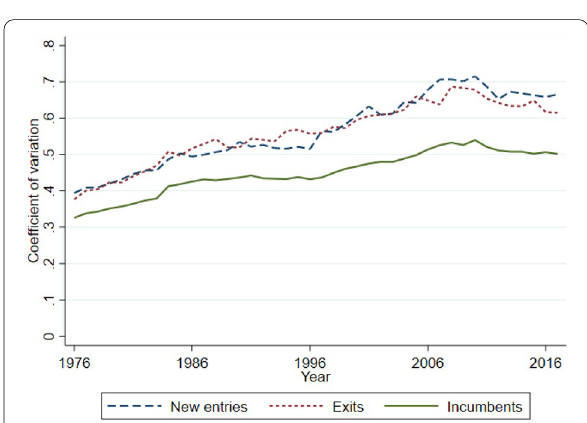
Fig. 3 Wage dispersion dynamics of entering, exiting, and incumbent establishments in West Germany, as measured by the coefficient of